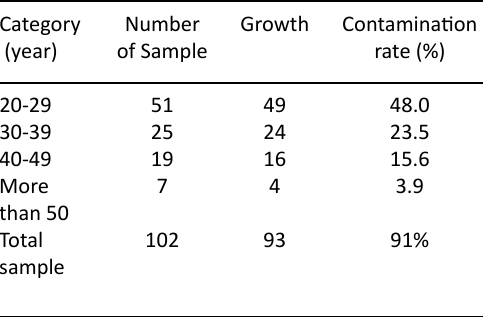
table 1. Distribution of examined populations